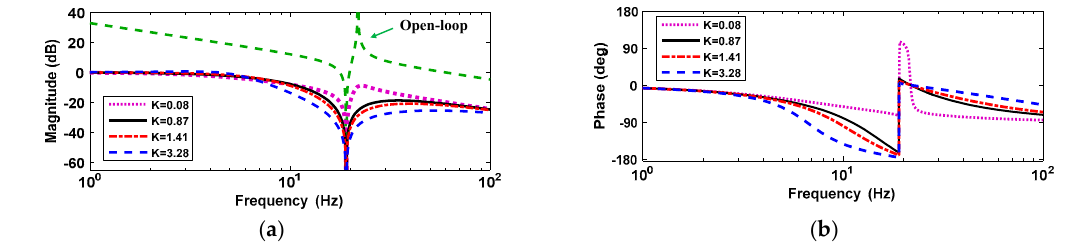
. . θ  to θ  with different parameters K : ( a ) θ θ ff erent parameters K : ( a ) amplitude– d m m with di d to